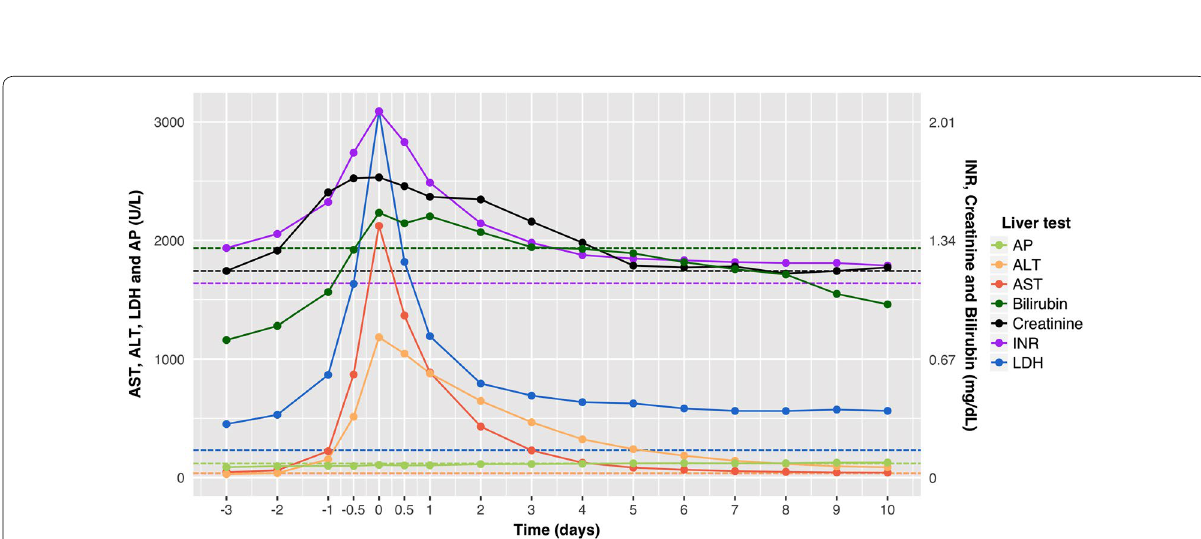
Fig. 5 Time trend of liver tests in hypoxic hepatitis of the ASTmax subgroup 5-10x ULN. Time trend of the median AP, ALT, AST, bilirubin, creatinine, INR and LDH levels in hypoxic hepatitis. T-ASTmax is designated as time 0. AST, ALT, LDH and AP levels are measured in U/L and are plotted using the left y-axis. Bilirubin and creatinine levels are measured in mg/dL and plotted using the right y-axis. INR has no unit, but is also plotted using the right y-axis. AP alkaline phosphatase, ALT alanine aminotransferase, AST aspartate aminotransferase, INR international normalized ratio, LDH lactate dehydrogenase